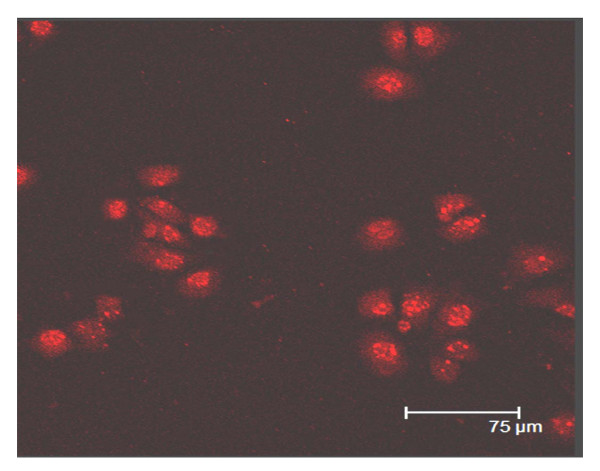
Immunofluorecent staining of SSCs, detected SSEA-4 positive cells. Cells were observed under immune fluorescence microscope(×400).